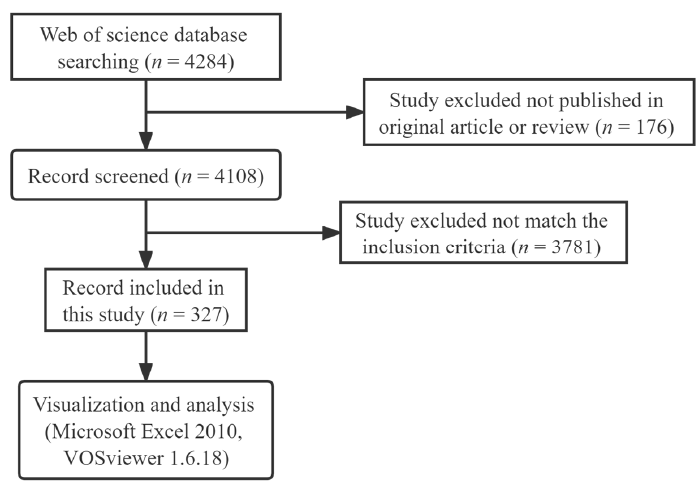
Figure 1. Flowchart of literature selection.